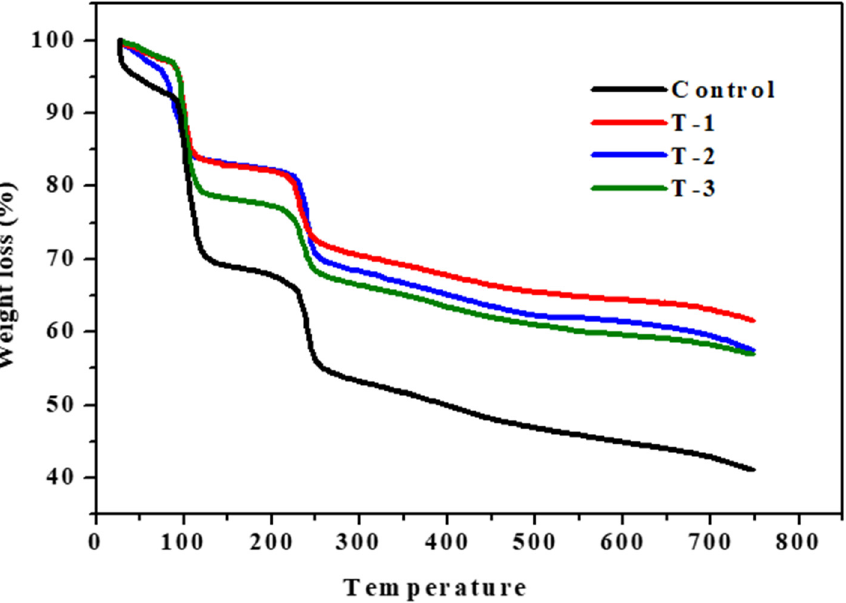
Figure 4. Thermogravimetric analysis (TGA) of T-1: (SA:SE 70:30); T-2: (SA:SE 80:20); and T-3: (SA:SE 90:10) hydrogels in comparison to control hydrogel.